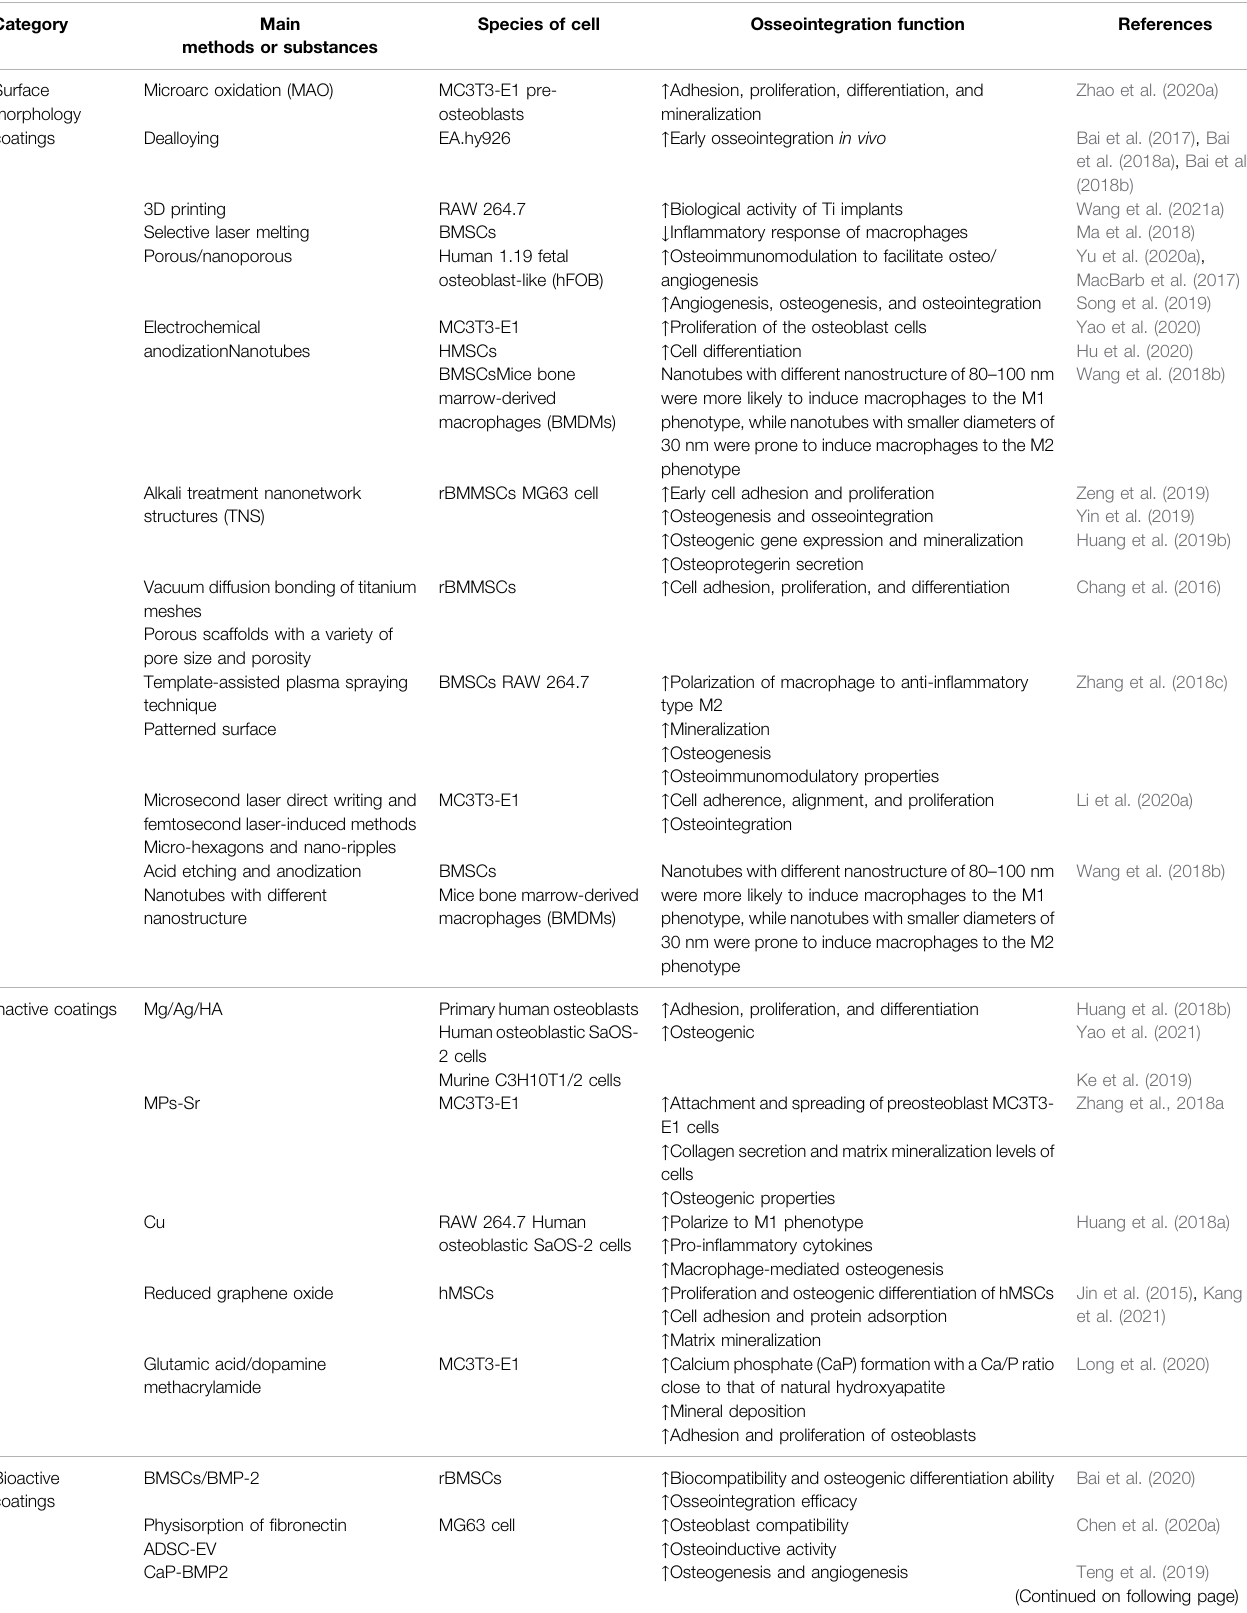
TABLE 1 | Recent development of osteogenic coatings on titanium